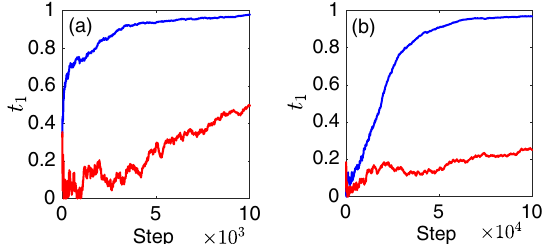
FIG. 7. Training process of the entanglement-assisted PCA. Blue plots: Performance of entanglement-assisted PCA. Red plots: The performance of classical PCA. (a) M ¼ 20 , N